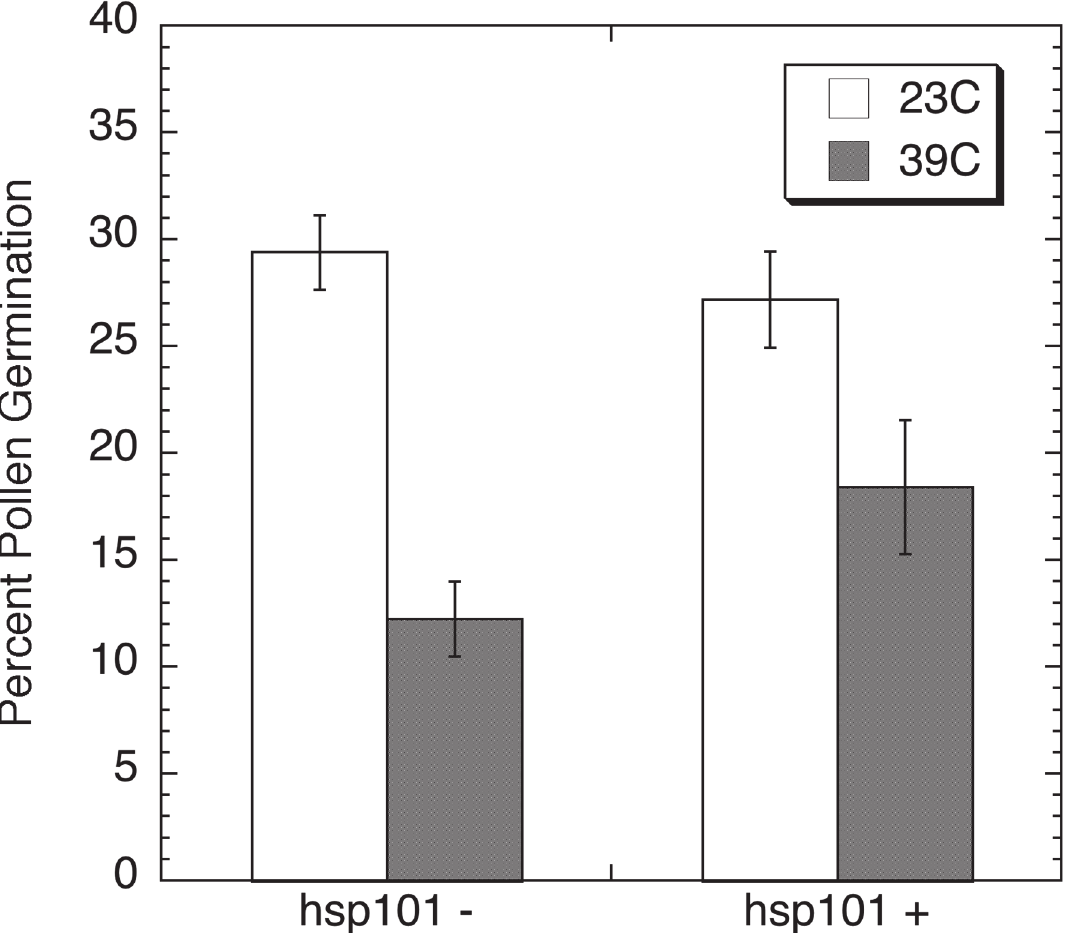
Fig 8. Cotton pollen germination following a high temperature challenge. Graph showing the percent germination of control (AtHSP101 minus, plant 39) and transgenic (AtHSP101 plus, plant 40) pollen from greenhouse grown cotton germinated for one hour at either 23°C or 39°C on the solid media described by Burke et al. [17]. Error bars represent Standard Deviation and the sample size was n = 20, p value is